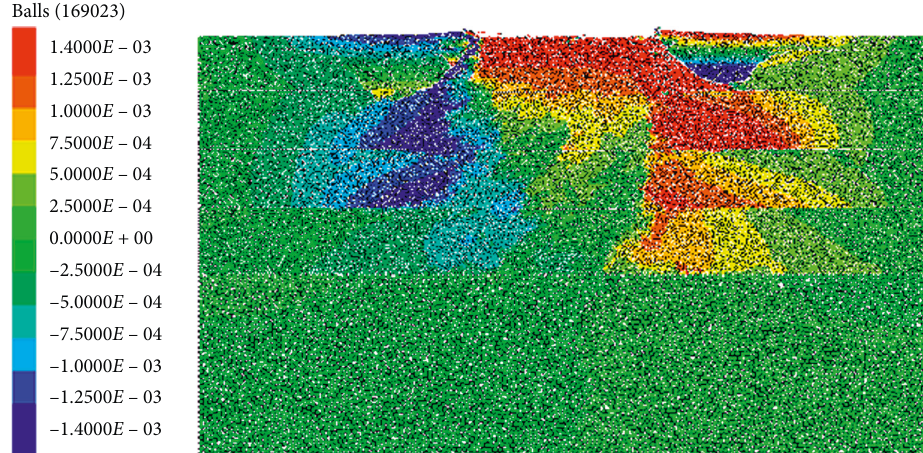
Figure 19: Horizontal displacement nephogram of discrete element